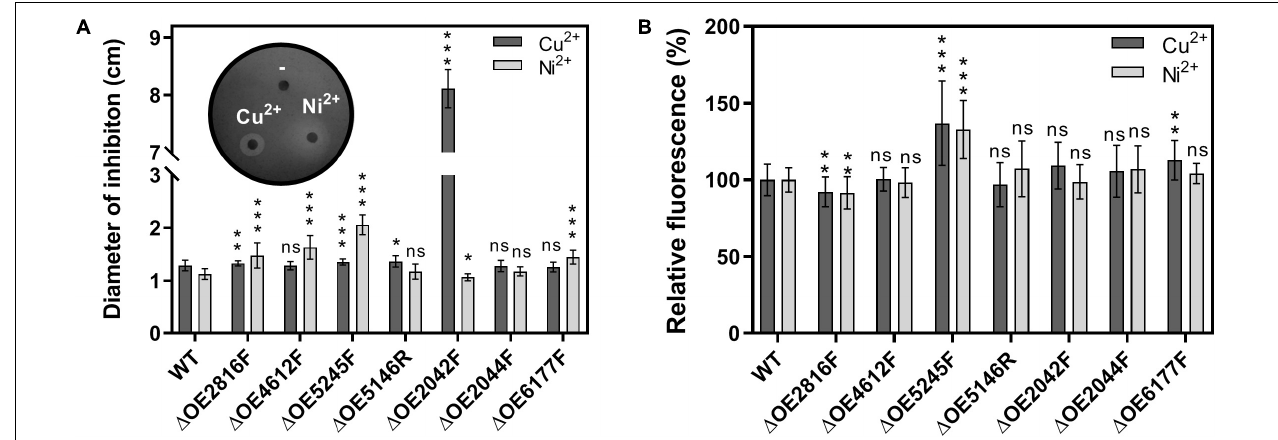
FIGURE 7 | Characterization of H. salinarum R1 wild type (WT) and deletions strains exposed to metal ions. (A) Agar diffusion assays testing the metal sensitivity by measuring the zones of growth inhibition surrounding Cu 2 + or Ni 2 + soaked filter papers. (B) Fluorescence-based adhesion assays. Biofilms were grown in complex medium for 14 days and sessile cells were treated with Cu 2 + or Ni 2 + for 24 h. The diagram shows the relative fluorescence based on adherent cells of the deletion strains relatively compared to the wild type (set to 100%). The significance of the quantifications in gene deletion strains compared to the wild type strain was assessed by t -test (ns, not significant, ∗ significant = p < 0.05, ∗∗ highly significant = p < 0.01, ∗∗∗ extremely significant = p < 0.001).